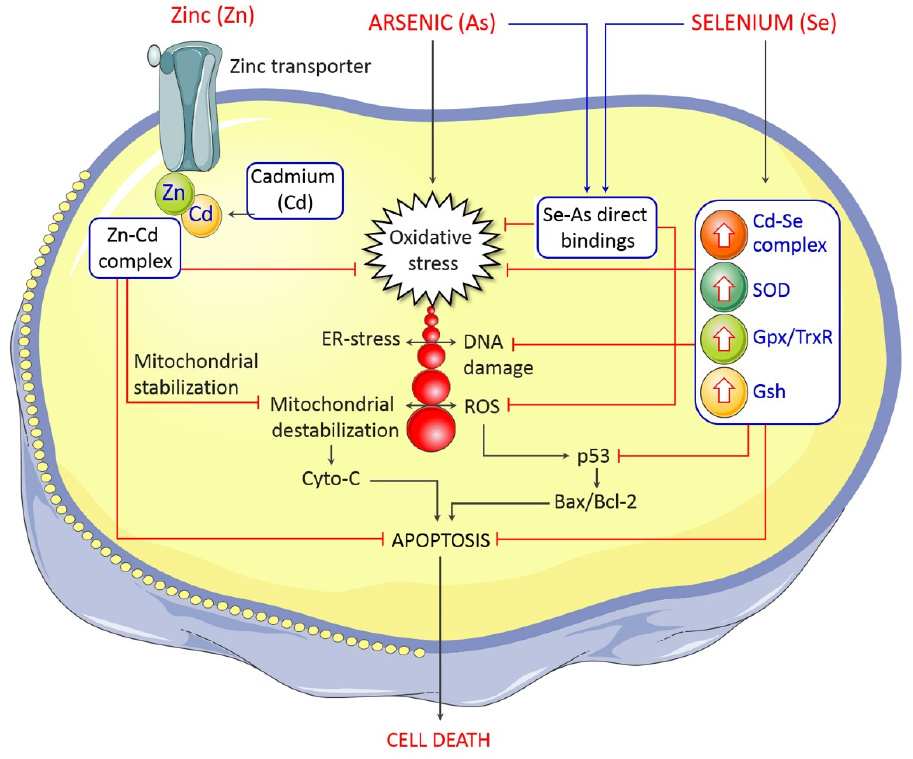
Figure 6. Possible protective mechanism of selenium and zinc against As toxicity. Arsenic induces oxidative stress, followed by DNA damage, ER stress, and mitochondrion dysfunction, which subsequently trigger apoptosis. Se–As complex inhibits oxidative stress, and Cd–Se prevents ROS production, DNA damage, and apoptosis. Additionally, Zn–Cd complex activates mitochondrial stabilization and inhibits oxidative stress and apoptosis.